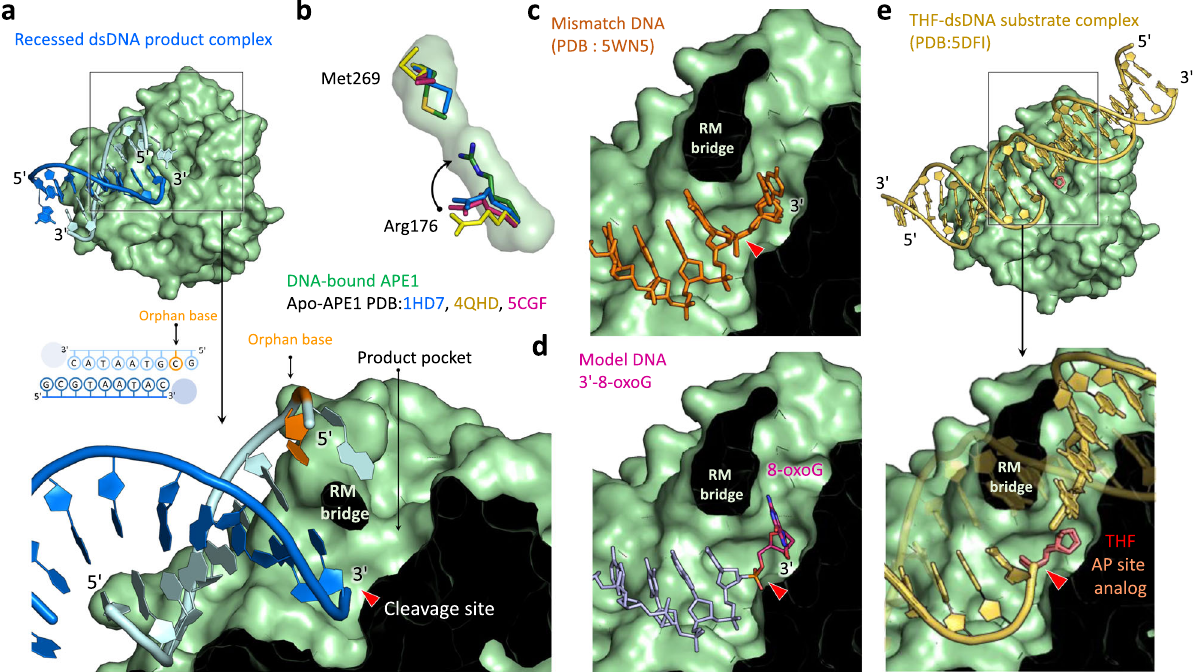
Fig. 5 The structures of RM bridge and product pocket in the active site of APE1. a The close-up view of the active site in mAPE1-recessed-dsDNA product complex, including the terminal of the dsDNA product, the RM bridge, and the product pocket. b Structural alignment of Arg176 and Met269 in apo- or DNA bound APE1 structures. The PDB entry of apo-APE1 structures are 1HD7, 4QHD, and 5CGF. c – e The close-up view of a normal cytosine base, an AP site analog, and a damaged 8-oxoG base in the product pocket. The cytosine coordinates are extracted from the hAPE1-mismatched dsDNA substrate complex structure (PDB entry: 5WN5). The AP site analog coordinates are extracted from the hAPE1 AP site analog-containing dsDNA complex structure (PDB entry: 5DFI). The coordinates of the damaged 8-oxoG base are generated by the molecular modeling conducted in this